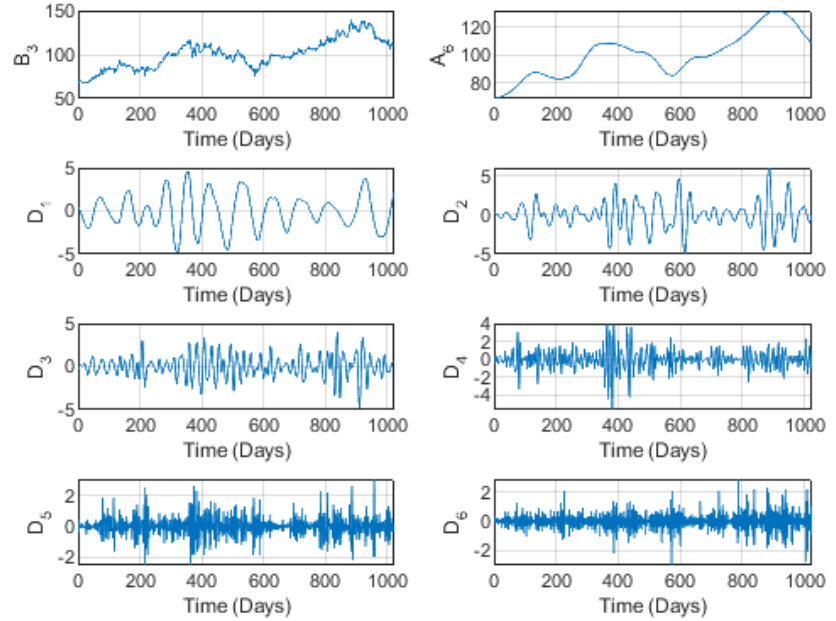
Figure 5. The wavelet decomposition of the STC brand B 3 prices at level 4.